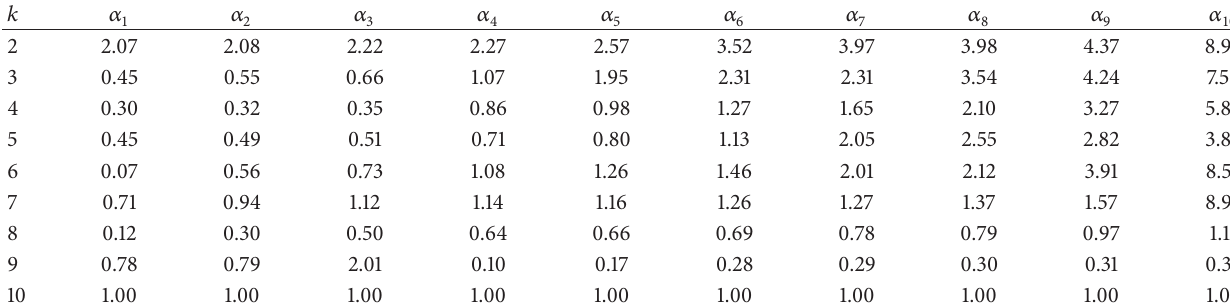
Table 7: The value of 𝛼 in 𝑘